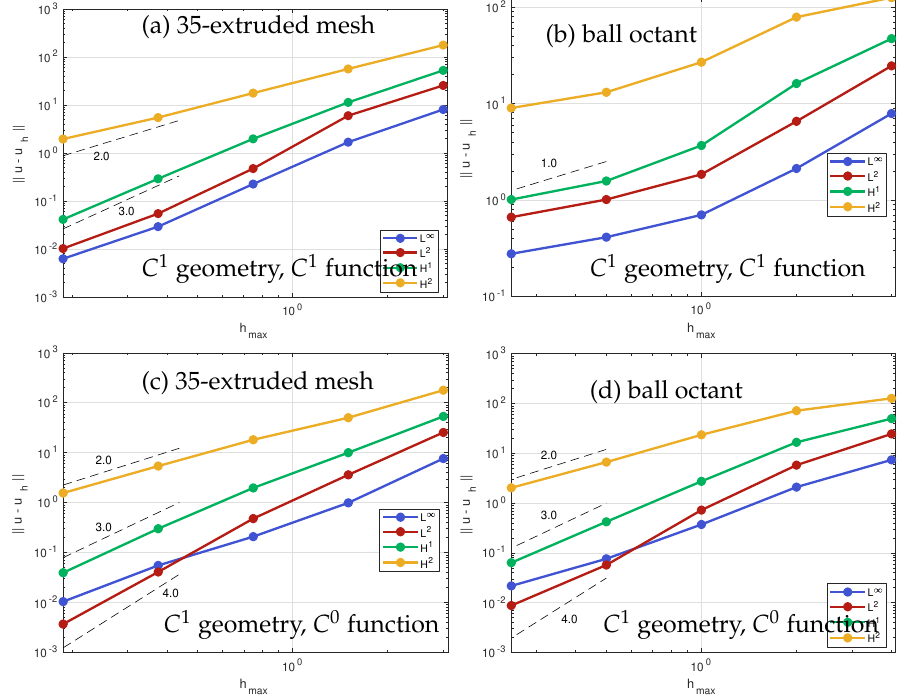
Figure 10. Convergence of tri-3 C 1 spline and variants for the biharmonic